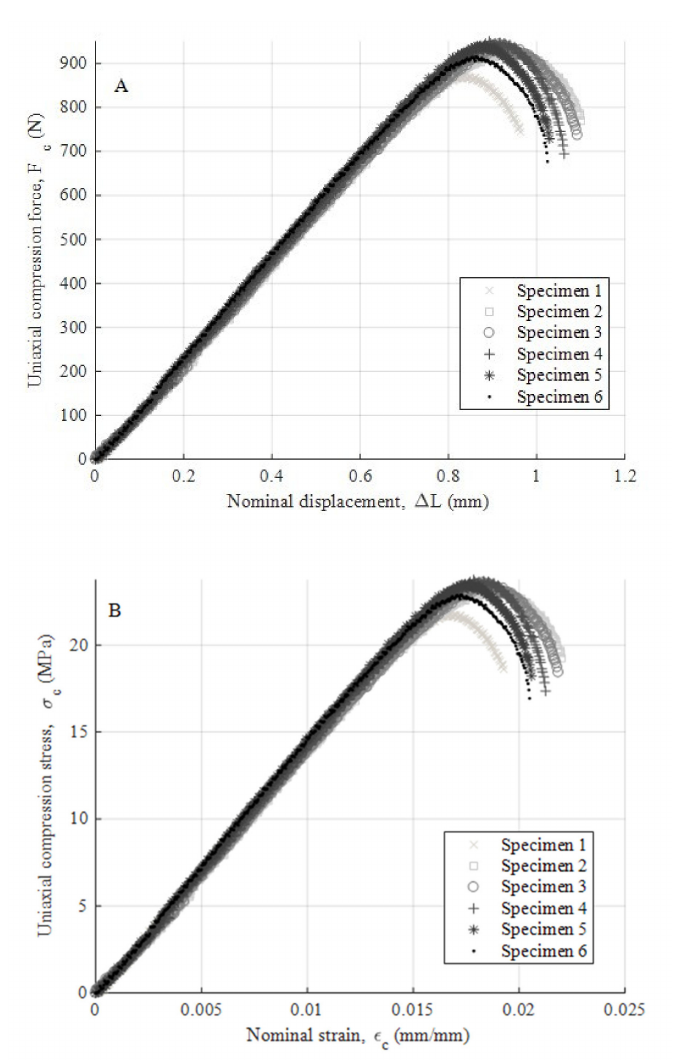
Figure 8. Curves for Z-axis specimens related to compression force versus nominal displacements ( A ) and compression stress versus nominal strain ( B